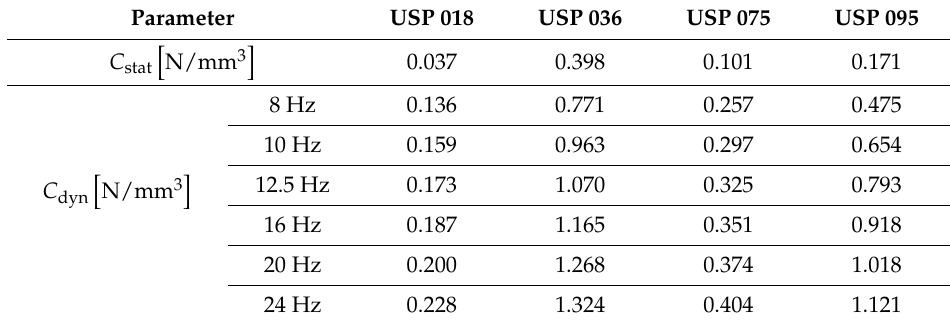
Table 1. The static and dynamic bedding moduli of the four tested under sleeper pads (USP). Parameter USP 018